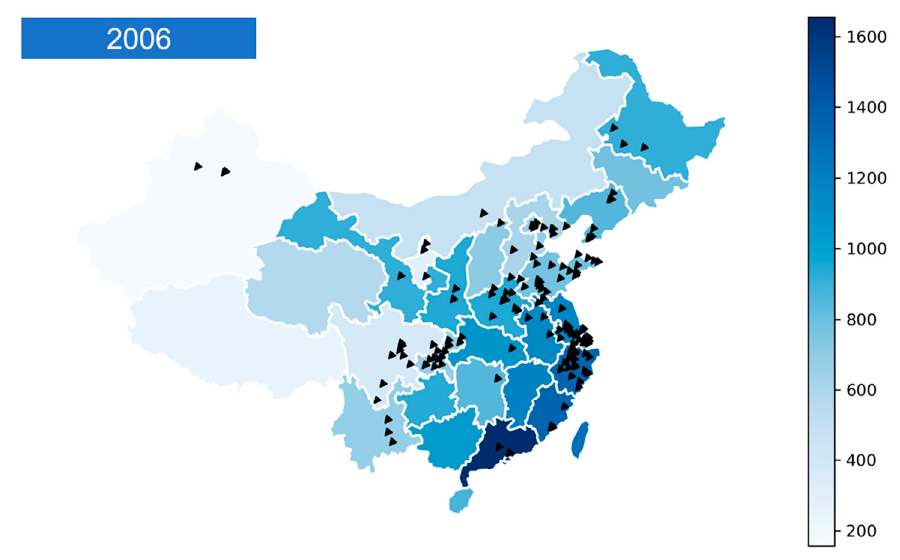
Figure A5. Annual average precipitation levels in sample year (2006), and locations of wastewater treatment plants included in the sample.